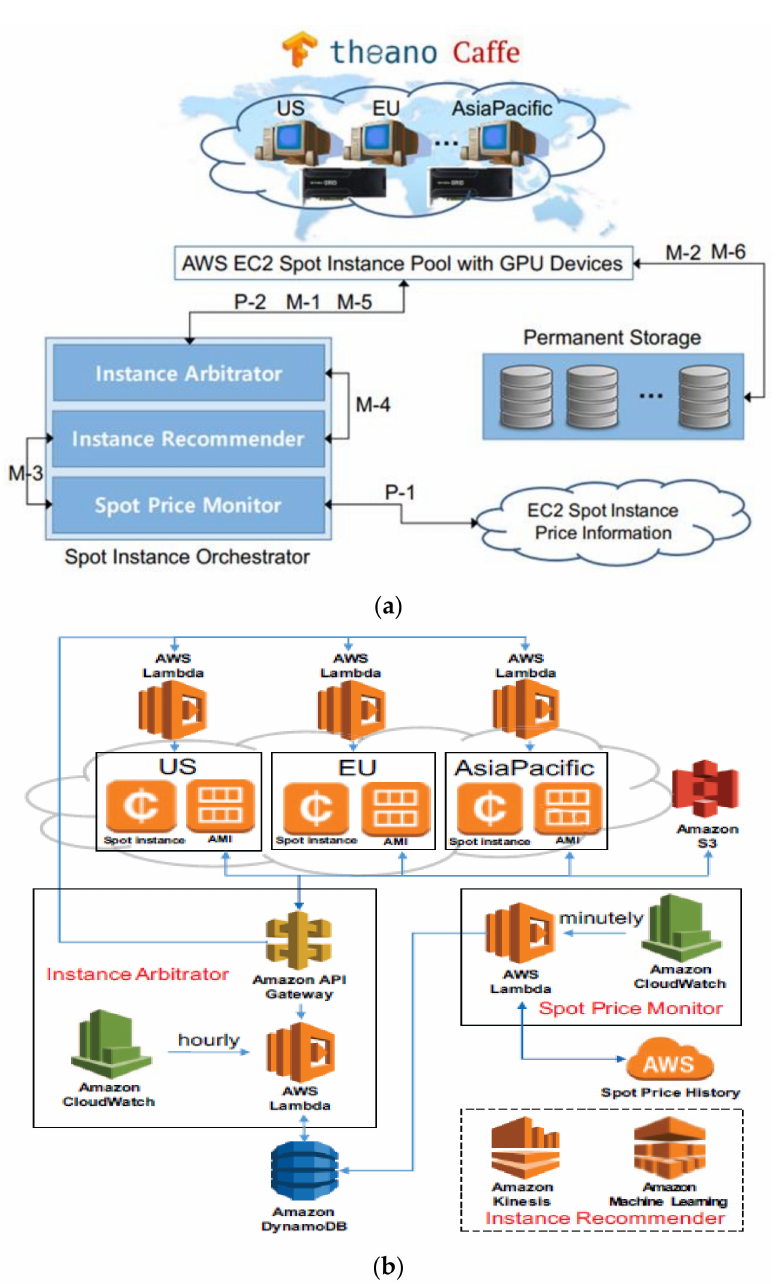
Figure 1. ( a ) DeepSpotCloud architecture and ( b ) the implementation of DeepSpotCloud [12]. AWS: Amazon Web Services. (Reprinted with permission from ref. [12]. Copyright 2021